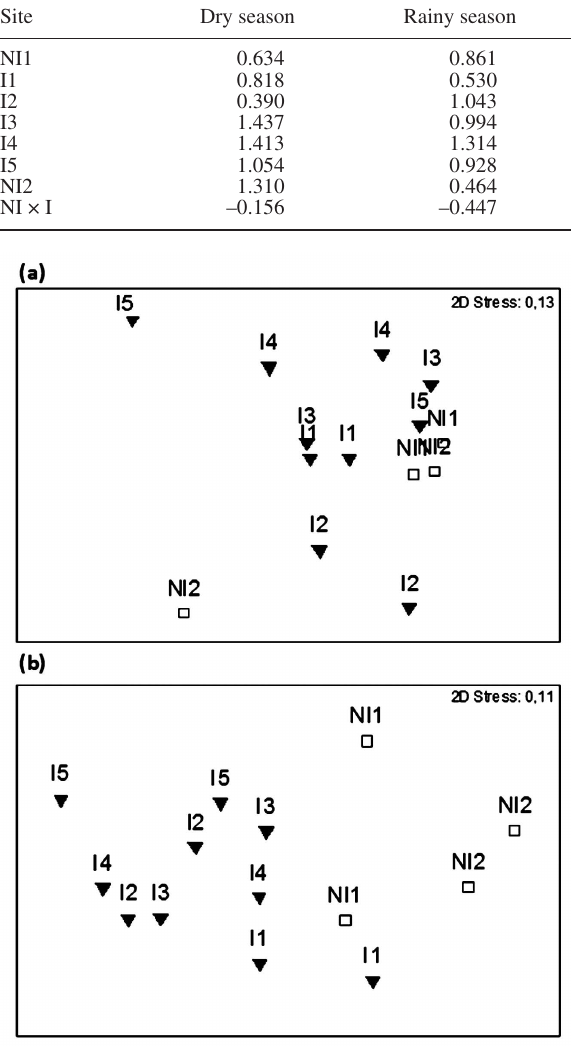
Table 6. – Index of Multivariate Dispersion (IMD) for impacted sites (I) and non-impacted sites (NI). Values of dispersion are shown for each sampling season.